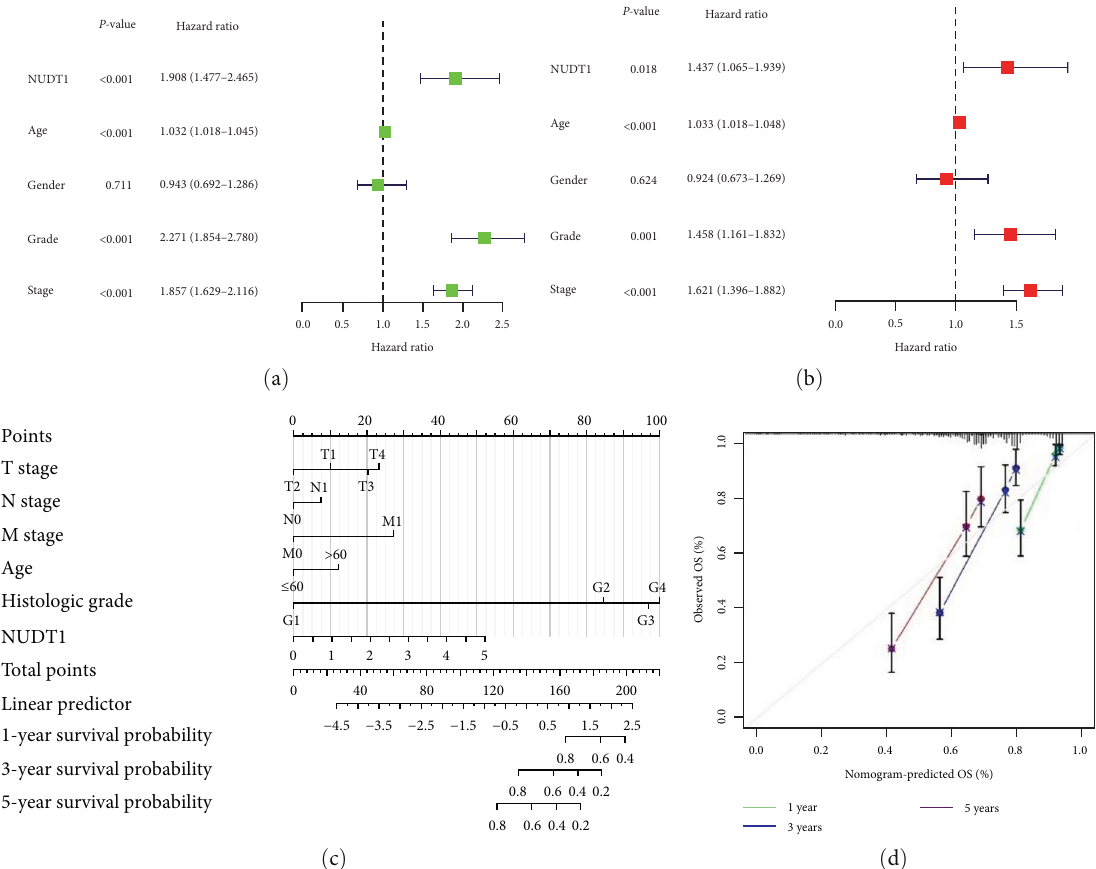
F IGURE 4: Prognosis evaluation of patients with ccRCC based on NUDT1: (a) the forest plots of univariate Cox regression analysis; (b) the forest plots of multivariate Cox regression analysis; (c) the nomogram based on NUDT1 and clinical characteristics; (d) the calibration curve of the